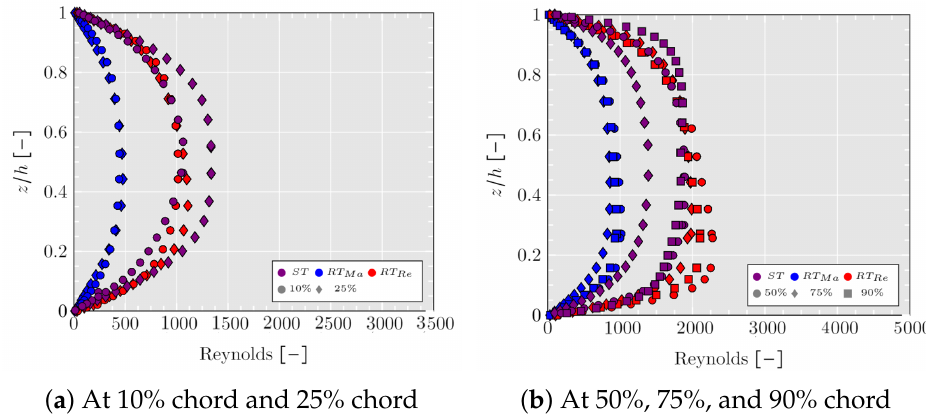
Figure 12. Local Reynolds number distribution in the clearance. ST and RT; VGT60; 0.5 mm tip height. In the figure, legend colors stand for each case, while shapes in gray determine each of the chord positions where data are taken.